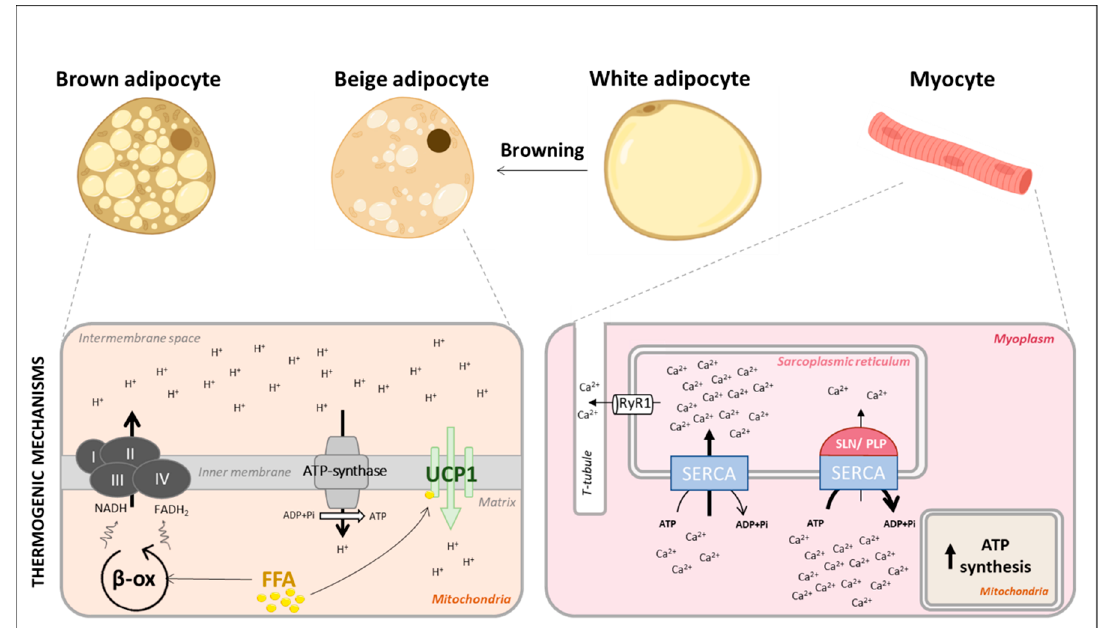
Figure 1. The main actors of adaptive thermogenesis and their principle thermogenic mechanisms. Adipose tissues and muscles are the main actors of adaptive thermogenesis. White adipocytes are not thermogenic per se but can undergo browning to generate beige adipocytes. Bottom left panel: Brown and beige adipocytes use free fatty acids (FFA) to fuel the mitochondrial β -oxidation. β -oxidation generates reduced compounds (NADH, FADH 2 ) whose oxidation is used by the respiratory electron transport chain (complex I, II, III, IV) to pump protons (H + ) into the intermembrane space. Thus, an electrochemical gradient is created and used by ATP synthase to produce ATP. UCP1 is present in the inner mitochondrial membrane and activated by FFA. UCP1 acts as a proton channel to dissipate the electrochemical gradient without producing ATP. Thus, to match the inefficient ATP production, the metabolism must increase and heat is produced. Bottom right panel: Myocytes express SERCA that is located in the sarcoplasmic reticulum (SR) membrane. SERCA transfers calcium (Ca 2+ ) from the cytosol to SR lumen using ATP hydrolysis. The calcium gradient generated by SERCA is dissipated by ryanodine receptor (RyR1). SERCA transport activity can be inhibited by two peptides: phospholamban (PLP) or sarcolipin (SLN), but its ATPase activity remains. To match Ca 2+ transport, ATP mitochondrial synthesis increases and heat is produced.